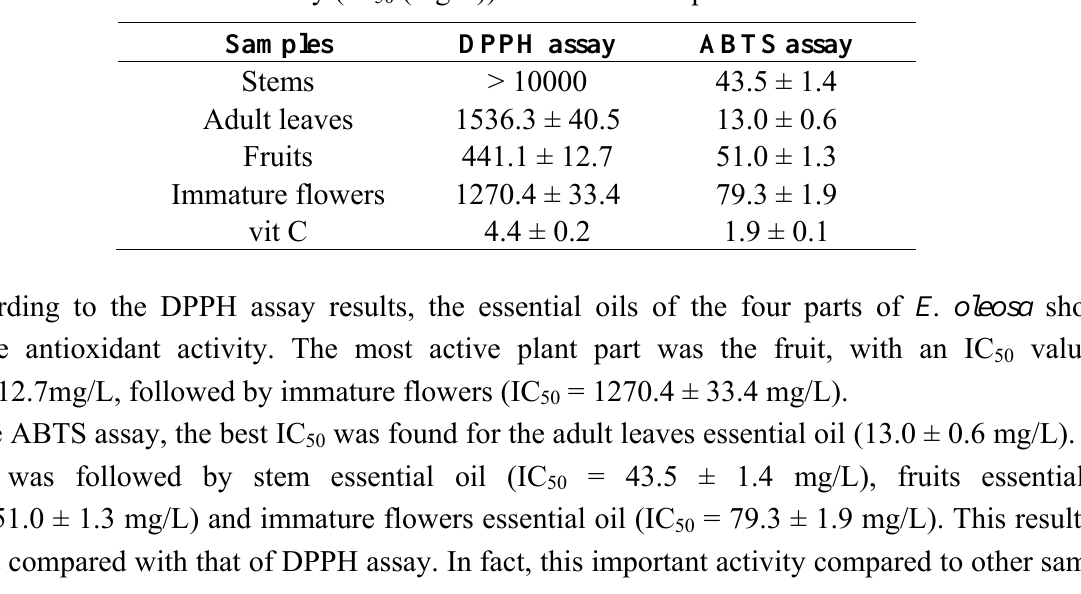
Table 2. Antioxidant activity (IC